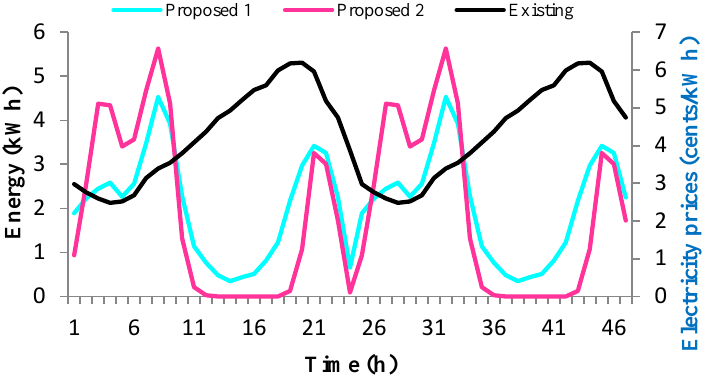
Figure 10. Comparison of energy and cost between proposed and existing scenario over 48 h time period.